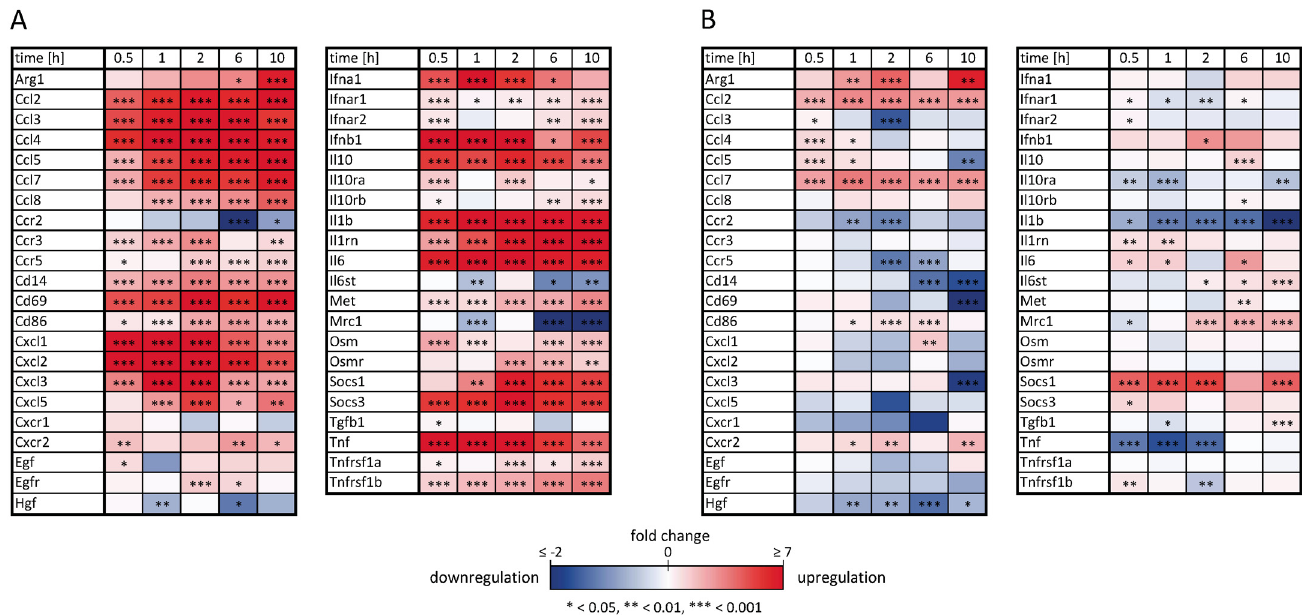
Fig 1. Inflammatory gene expression patterns of activated macrophages. Receptor and mediator transcript expression pattern of (A) M1 macrophages stimulated with LPS and (B) M2 macrophages stimulated with the interleukins IL-4 and IL-13 for 0.5, 1, 2, 6, and 10 measured using the high-throughput Taqman Fluidigm system. Data is analyzed using multivariable statistics and normalized to untreated controls. Genes marked in red and blue represent upregulated and downregulated genes, respectively ( * p (cid:1) 0.05, ** p (cid:1) 0.01, *** p (cid:1) 0.001). For mean expression values with standard deviation, number of samples and p-values for regulation compared to untreated controls we refer to S1 Dataset.